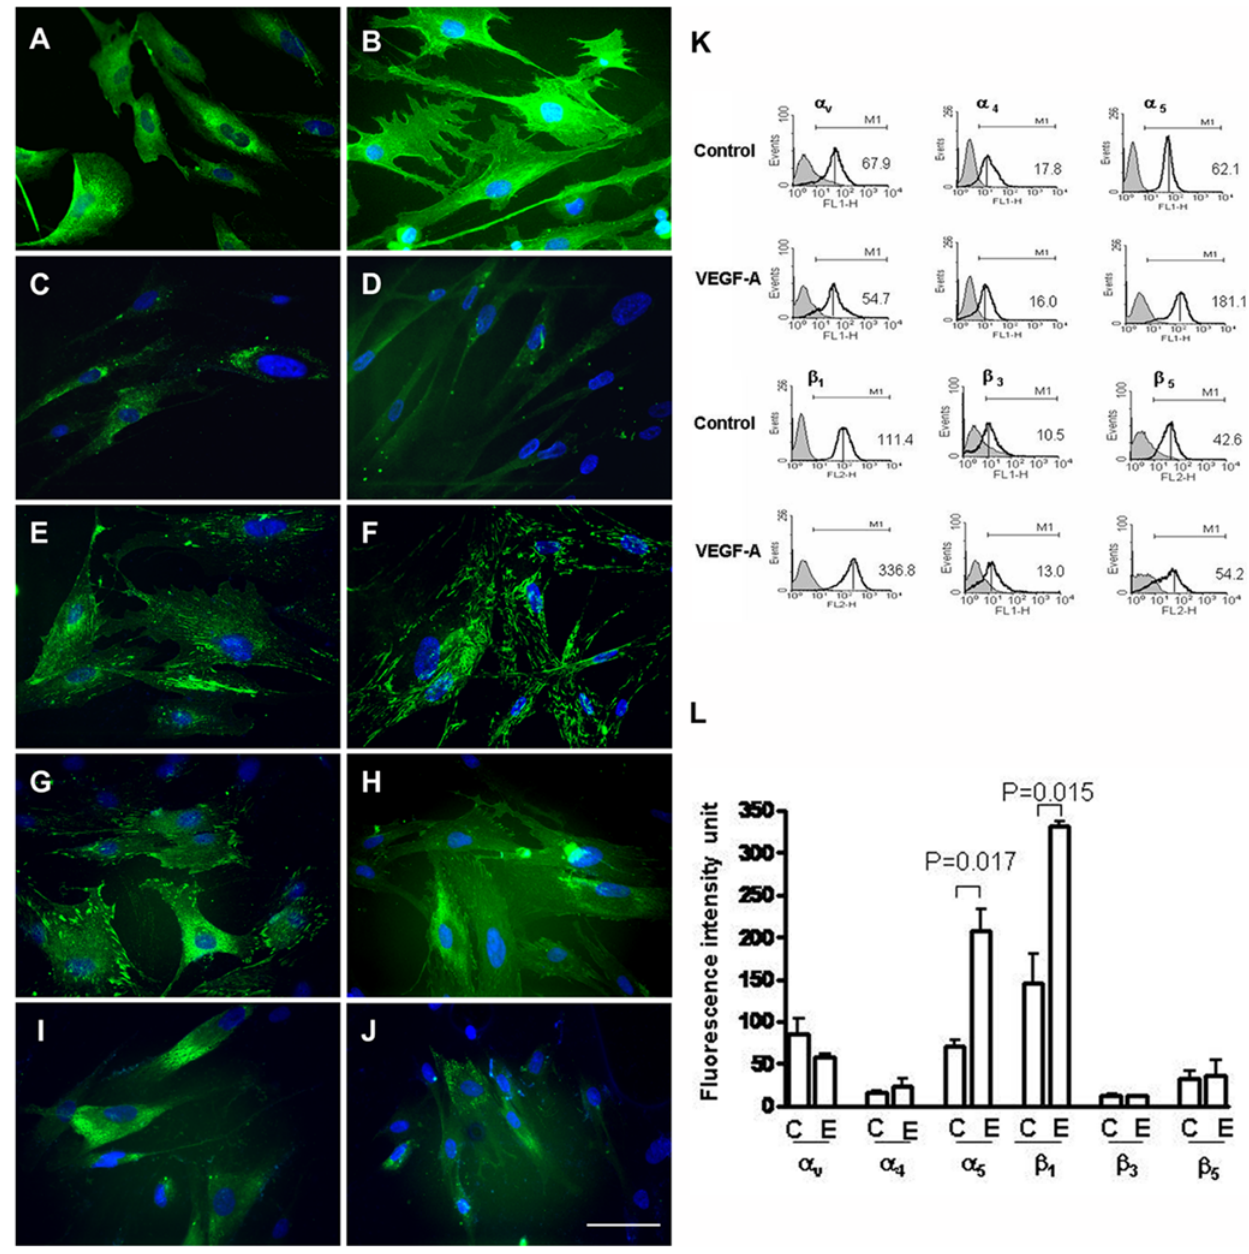
Figure 3. Integrin expression at the surface of human placental multipotent mesenchymal stromal cells (hPMSCs) before and after inducing differentiation into endothelial cells. Undifferentiated hPMSCs: A, C, E, G, I; differentiated hPMSCs: B, D, F, H, J. The cells were immunostained using antibody against integrin (A, B) b 1 , (C, D) a 4 , (E, F) a 5 , (G, H) a v b 3 , or (I, J) a v b 5 . Scale bar: 10 m m. Immunofluorescence staining revealed significant increases in integrin a 5 and b 1 . (K) The change of hPMSC surface integrin expression after differentiation induced by VEGF-A was measured by flow cytometry and expressed in fluorescence intensity units. Change in fluorescence intensity is an index of integrin surface concentration per cell. (L) Quantification of specific mean fluorescence intensity (which corresponds to the increase in fluorescence intensity relative to second antibody alone) is shown ( 6 SD, n=3). The specific mean fluorescence intensity was higher for both integrins a 5 and b 1 in differentiated hPMSCs. C: controls; E: endothelial cell differentiation induced by VEGF-A. doi:10.1371/journal.pone.0006913.g003 migration of differentiated hPMSC in the presence of VEGF-A combination of VEGF-A and fibronectin produced an additive and fibronectin are dependent on integrin a 5 b 1 . effect (Fig. 4C). In contrast, neither vitronectin alone nor the combination of VEGF-A and vitronectin promoted migration (Fig. 4C). In the presence of antibodies to integrin a 5 or b 1 , cell migration to VEGF-A and fibronectin together was suppressed, whereas antibodies to a 4 , a v b 3 , or a v b 5 had no effect (Fig. 4D). These results suggest strongly that enhanced adhesion and